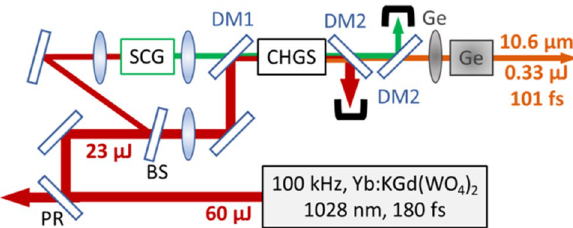
Figure 1. Schematic layout of the mid-infrared OPA. PR partial reflector, BS beam sampler, SCG supercontinuum generator based on a 6-mm-long YAG crystal, DM1 dichroic mirror, high reflection at 1.03 µm and high transmission at > 1.1 µm, DM2 dichroic mirror, high reflection at 1.0–1.2 µm and high transmission at 6–12 µm, CHGS 2-mm-long, uncoated Cd 0.65 Hg 0.35 Ga 2 S 4 crystal, Ge